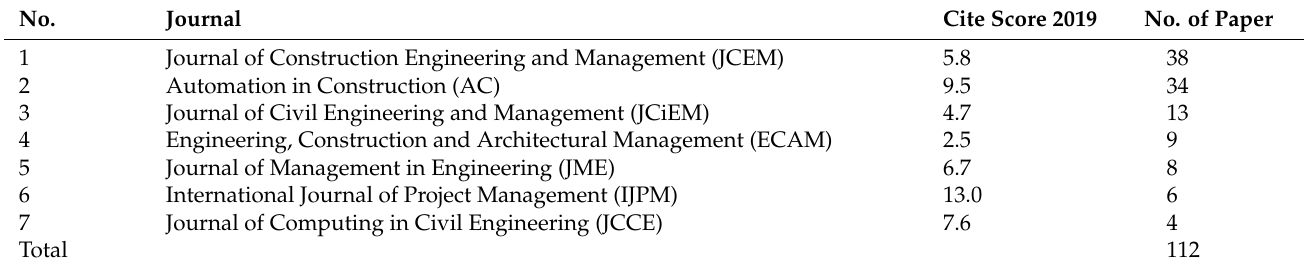
Table 2. Distribution of the selected papers among different journals.